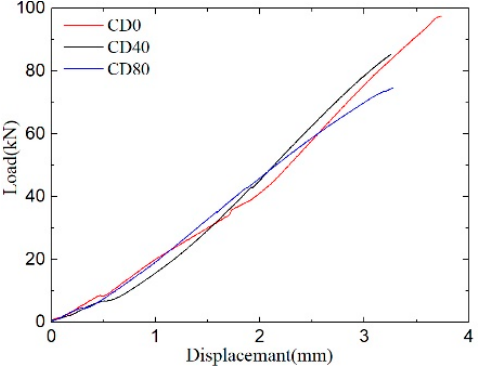
Figure 8. Typical strain-load curves of specimens with different defective.